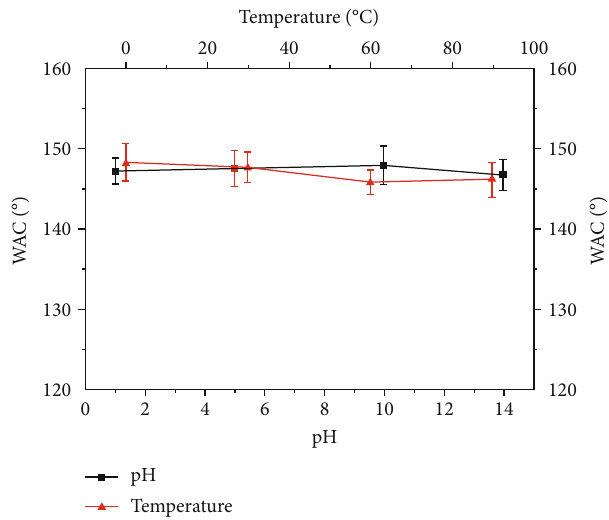
Figure 9: The water contact angle of the modi fi ed sponge after 4 hours in di ff erent pH and temperature environments.